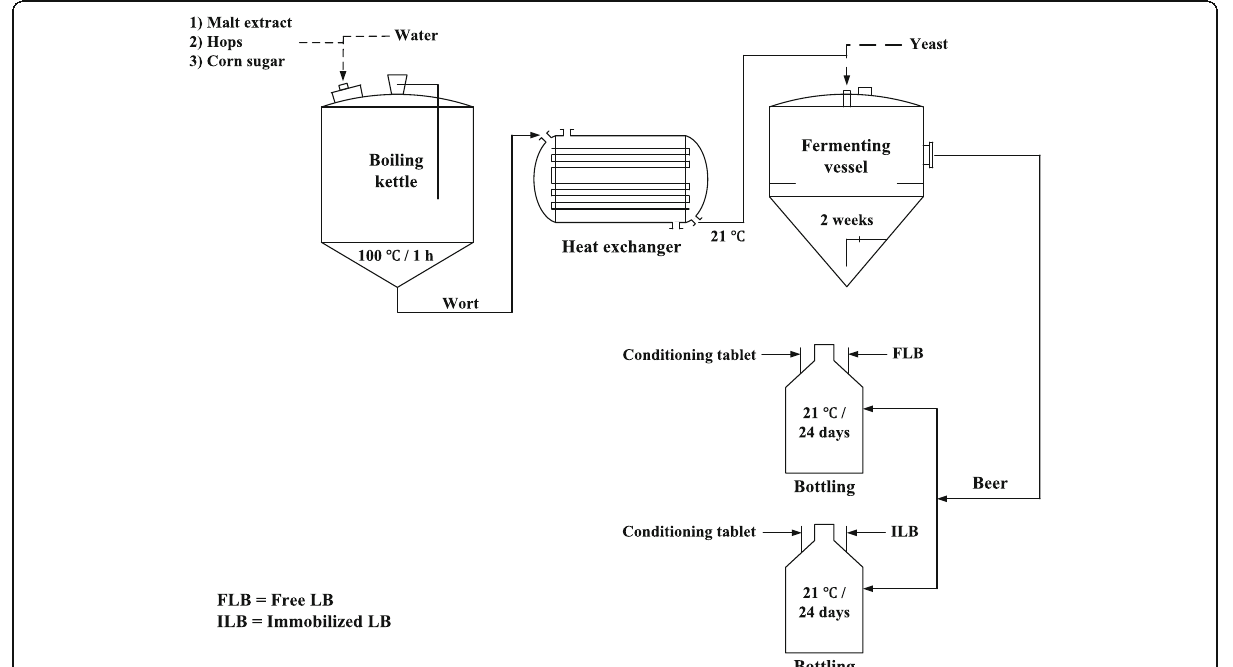
Fig. 1 Production of ale beer with FLB and ILB. FLB = free Lactobacillus brevis and ILB = immobilized Lactobacillus